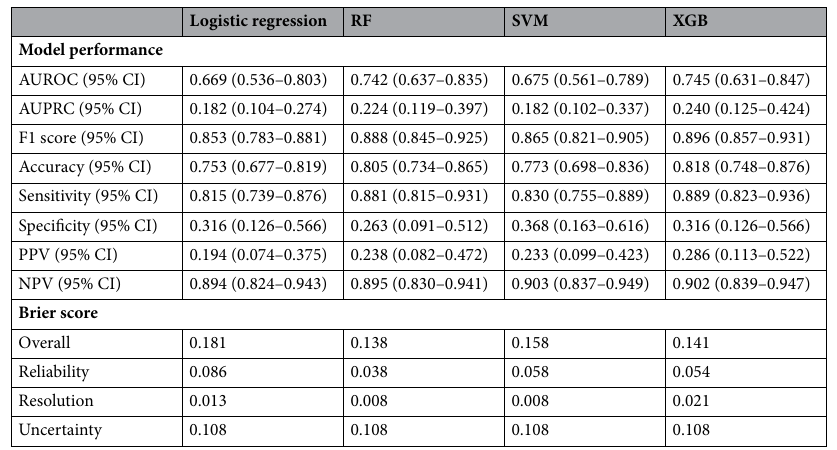
Table 2. Performance characteristics of models in the validation set for predicting clinically relevant AHREs in patients with pacemaker. AHREs atrial high-rate episodes, AUPRC area under the precision-recall curve, AUROC area under receiver operating characteristic, CI confidence interval, NPV negative predictive value, PPV positive predictive value, RF random forest, SVM support vector machine, XGB extreme gradient boosting.